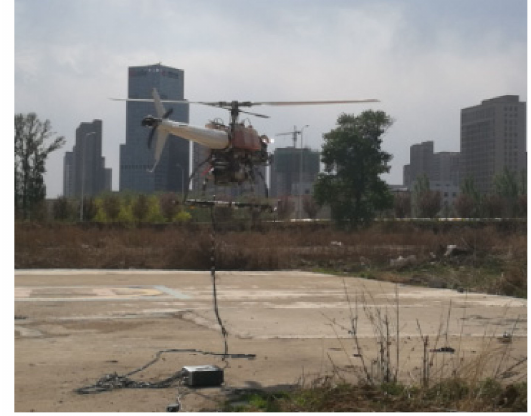
Figure 12. UAV Air Flight Vibration